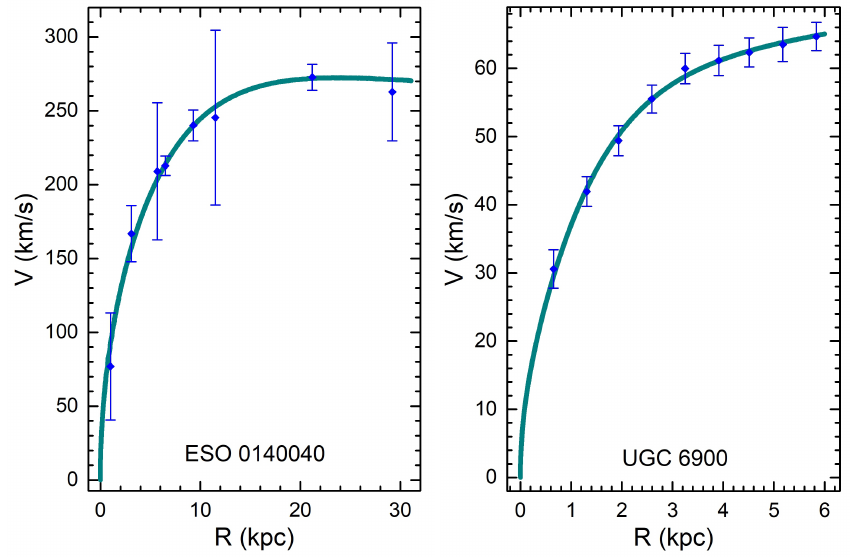
Figure 1. Rotation curves of two selected galaxies. The analysis on goodness-of-fitting to data leads to reduced χ 2 of 0.025 ± 0.218 and 0.297 ± 0.0780, respectively red